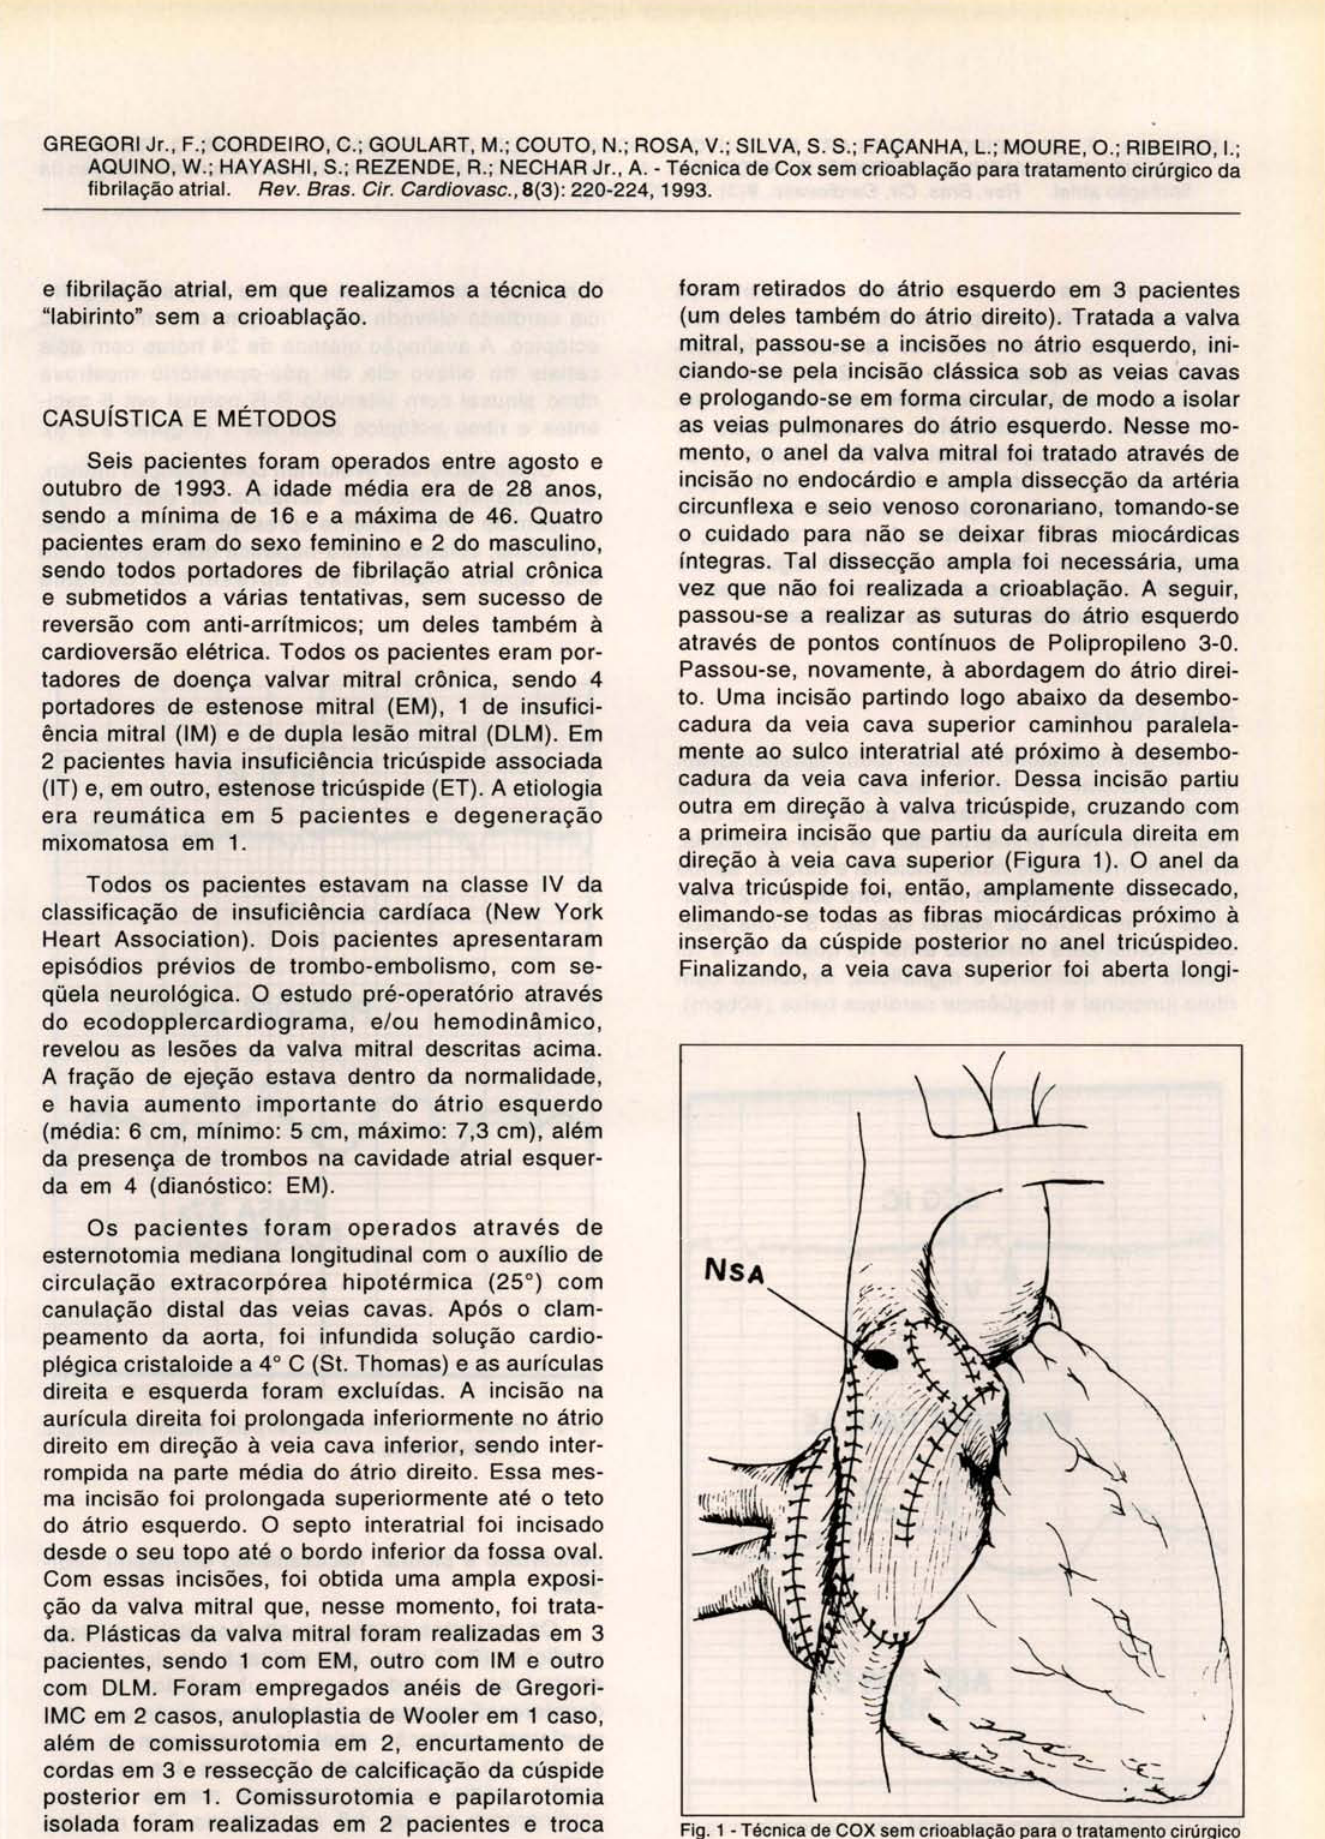
Fig. 1 -Técnica de COX sem crioablação para o tratamento cirúrgico da fibrilação